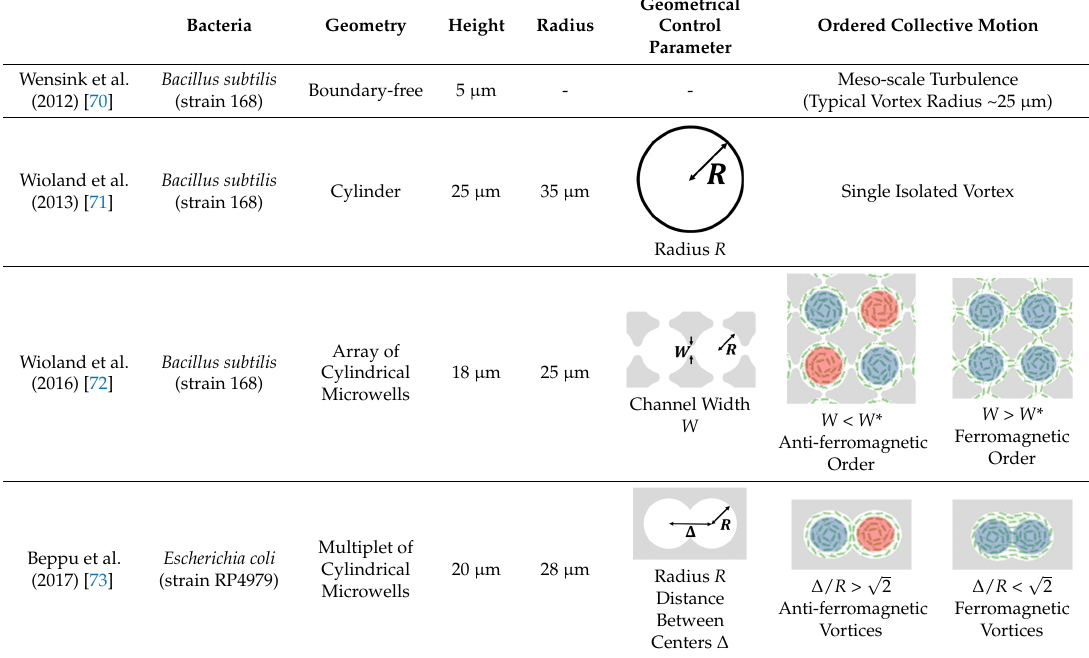
Table 2. Summary of microwell geometry. The boundary conditions by which collective motion of active bacterial swimmers are controlled are boundary-free, cylinder, the array of the cylinder, and overlapped cylinder. Geometrical Bacteria Geometry Height Radius Control Ordered Collective Motion Parameter